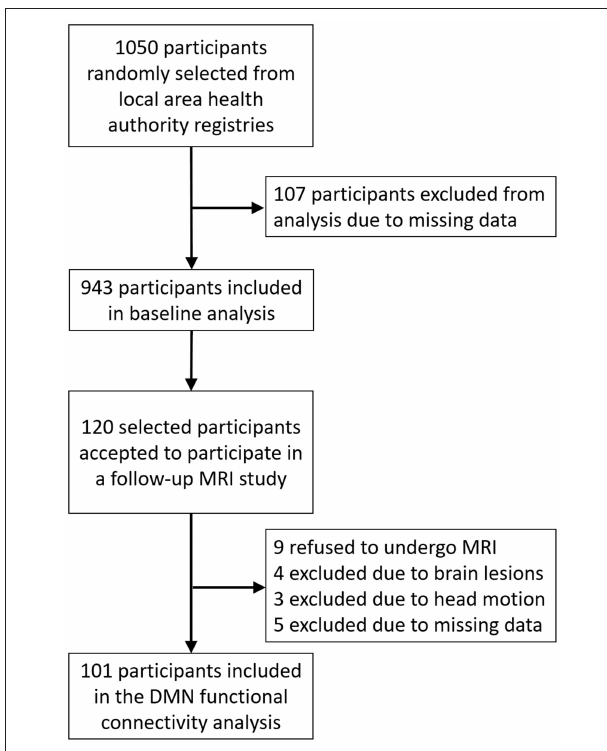
FIGURE 1 | Flow diagram of recruitment and study procedure.